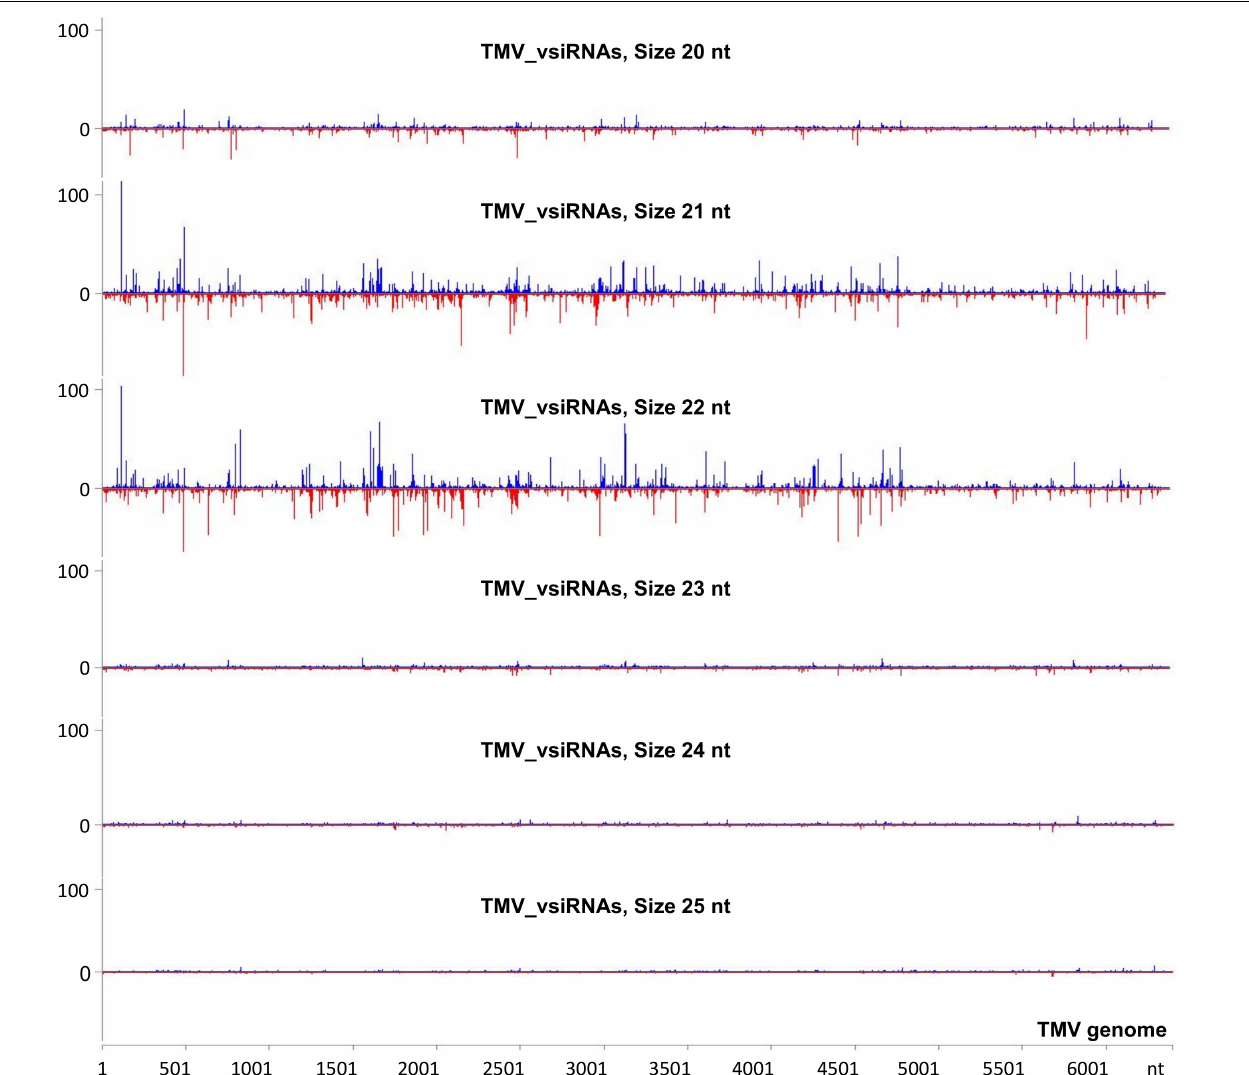
FIGURE 4 | Analysis of TMV-derived siRNAs in infected tobacco at 15 min post inoculation (mpi) employing small RNA NGS. MISIS software visualization shows the distribution of virus-derived small interfering RNAs (vsiRNAs) of 20–25 nt length along the sequence of a TMV reference genome (NC_001367.1). On the y -axis are shown the total read counts of vsiRNAs. Sense strand reads are shown with blue color above the x -axis, and antisense strand reads are shown with red color below the x